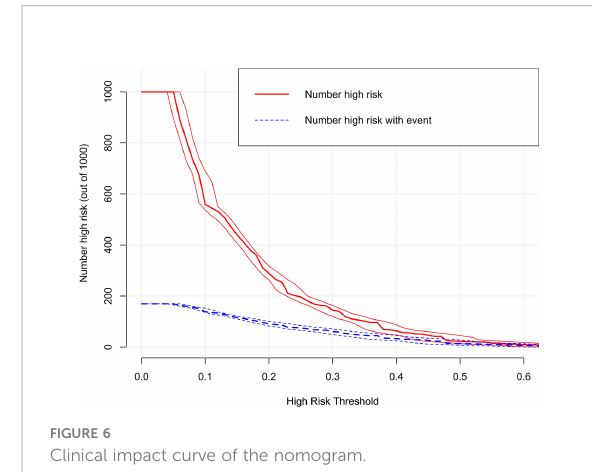
FIGURE 6 Clinical impact curve of the